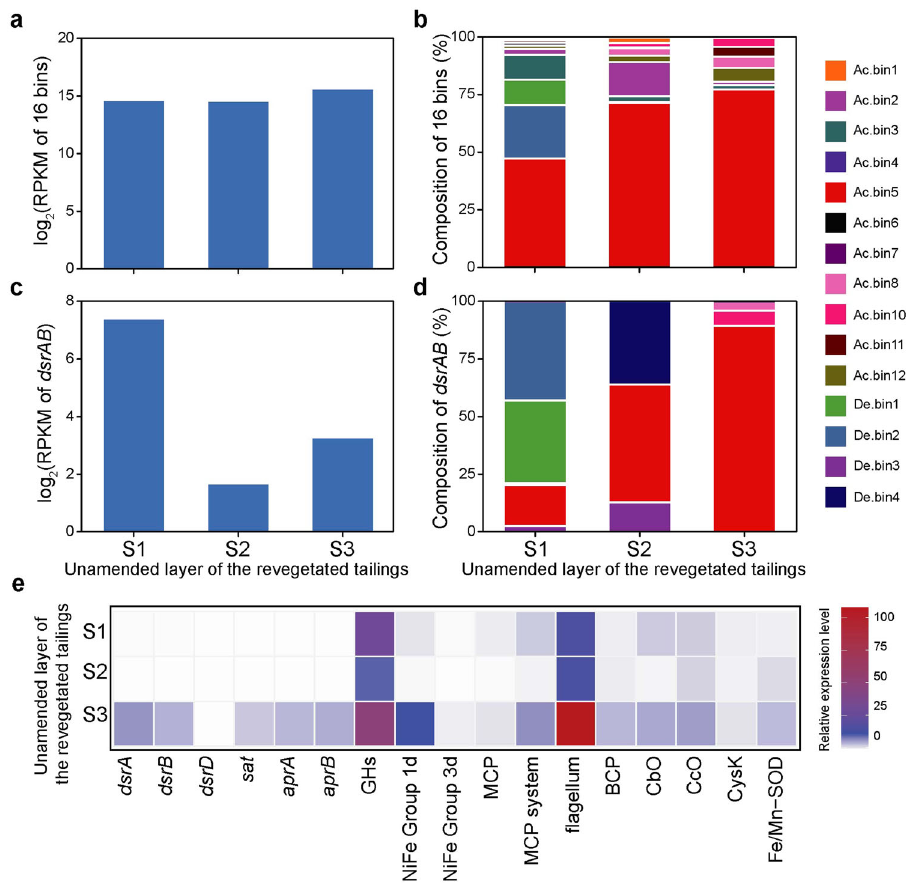
Fig. 5 Transcriptional pro fi le of the 16 SRMs reported in this study. a Overall transcript abundance of the 16 SRMs. b Relative contribution of individual SRMs to the overall transcript abundance of the 16 SRMs. c Overall transcript abundance of dsrAB of the 16 SRMs. d Relative contribution of individual SRMs to the overall transcript abundance of dsrAB of the 16 SRMs. e Relative expression levels of selected genes of Ac.bin5. Relative expression level was calculated based on the reads per kilobase per million mapped reads (RPKM) of a given selected gene normalized by that of the reference gene gyrA . The gene abbreviations are in accordance with those in Fig. 2. The results are based on three soil samples collected from the unamended layer of the revegetated